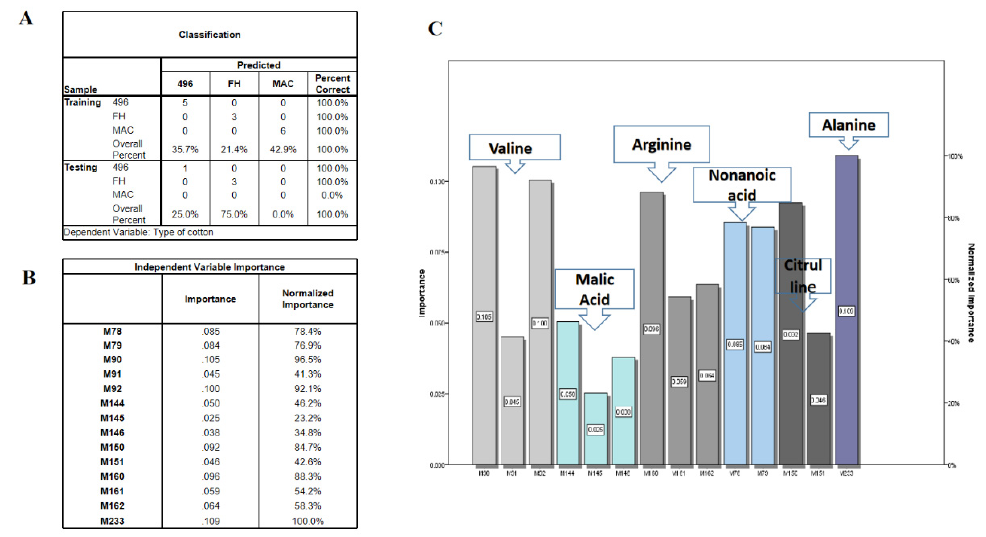
Figure 6. ( A ) Multilayer perceptron neural network results. ( B ) Independent variable importance. M78, M79 are nonanoic acid; M90–M92 are valine; M144–M146 refer to alanine; M150–M151 refer to citrulline; M160–-M162 refer to arginine; M233 is malic acid. ( C ) Fancier versions of importance